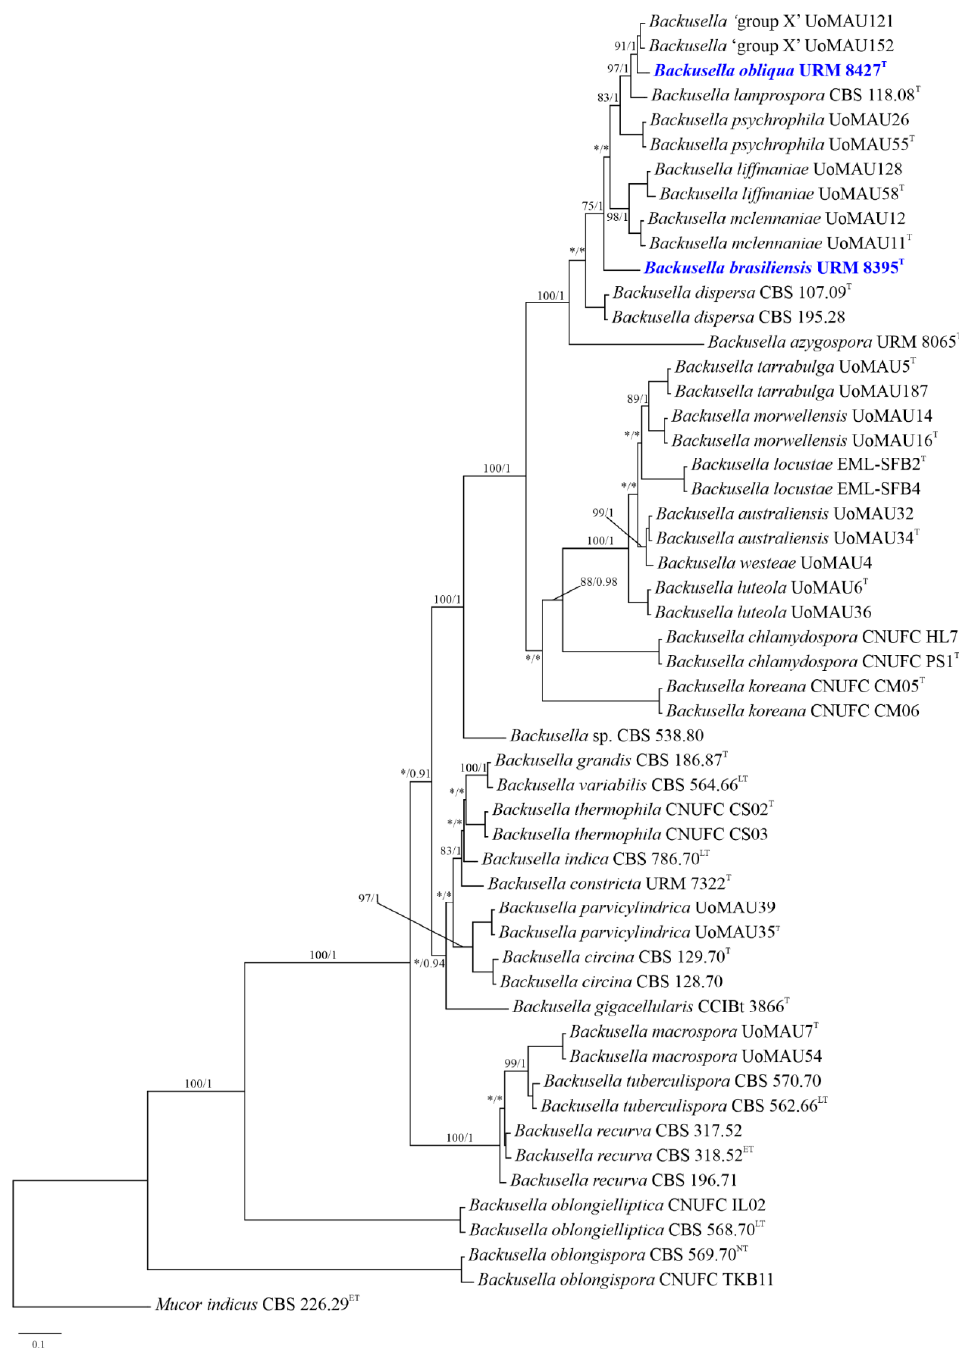
Figure 1. Phylogenetic tree of Backusella based on maximum likelihood analysis of a combined DNA dataset of internal transcribed spacer and large subunit sequences. Bootstrap values for Bayesian posterior probabilities over 0.90 and maximum likelihood higher than 70% are placed above the branches. Bootstrap values lower than 0.90 and 70% are marked with “*”. The bar indicates the number of substitutions per position. Mucor indicus CBS 226.29 was used as an outgroup. The newly generated sequences of B . obliqua URM 8427 and B. brasiliensis URM 8395 are indicated in blue. Ex- type, ex-epitype, ex-lectotype, and ex-neotype strains are marked with T, ET, LT, and NT, respec- tively.